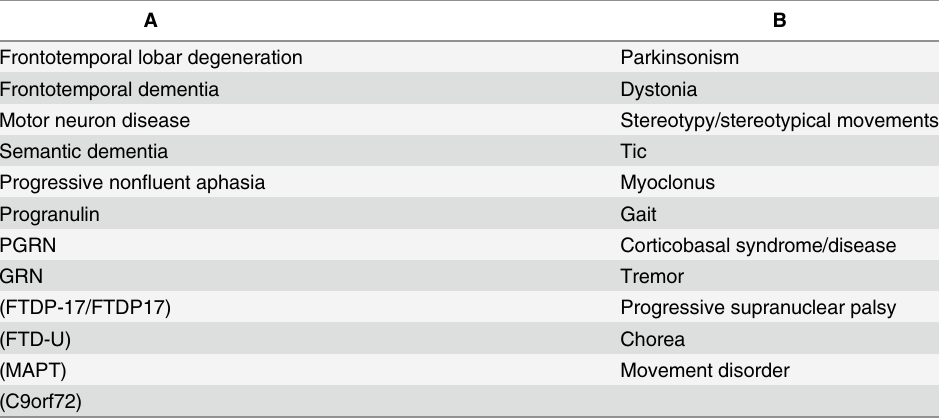
Table 1. Search terms used for PubMed and EMBASE